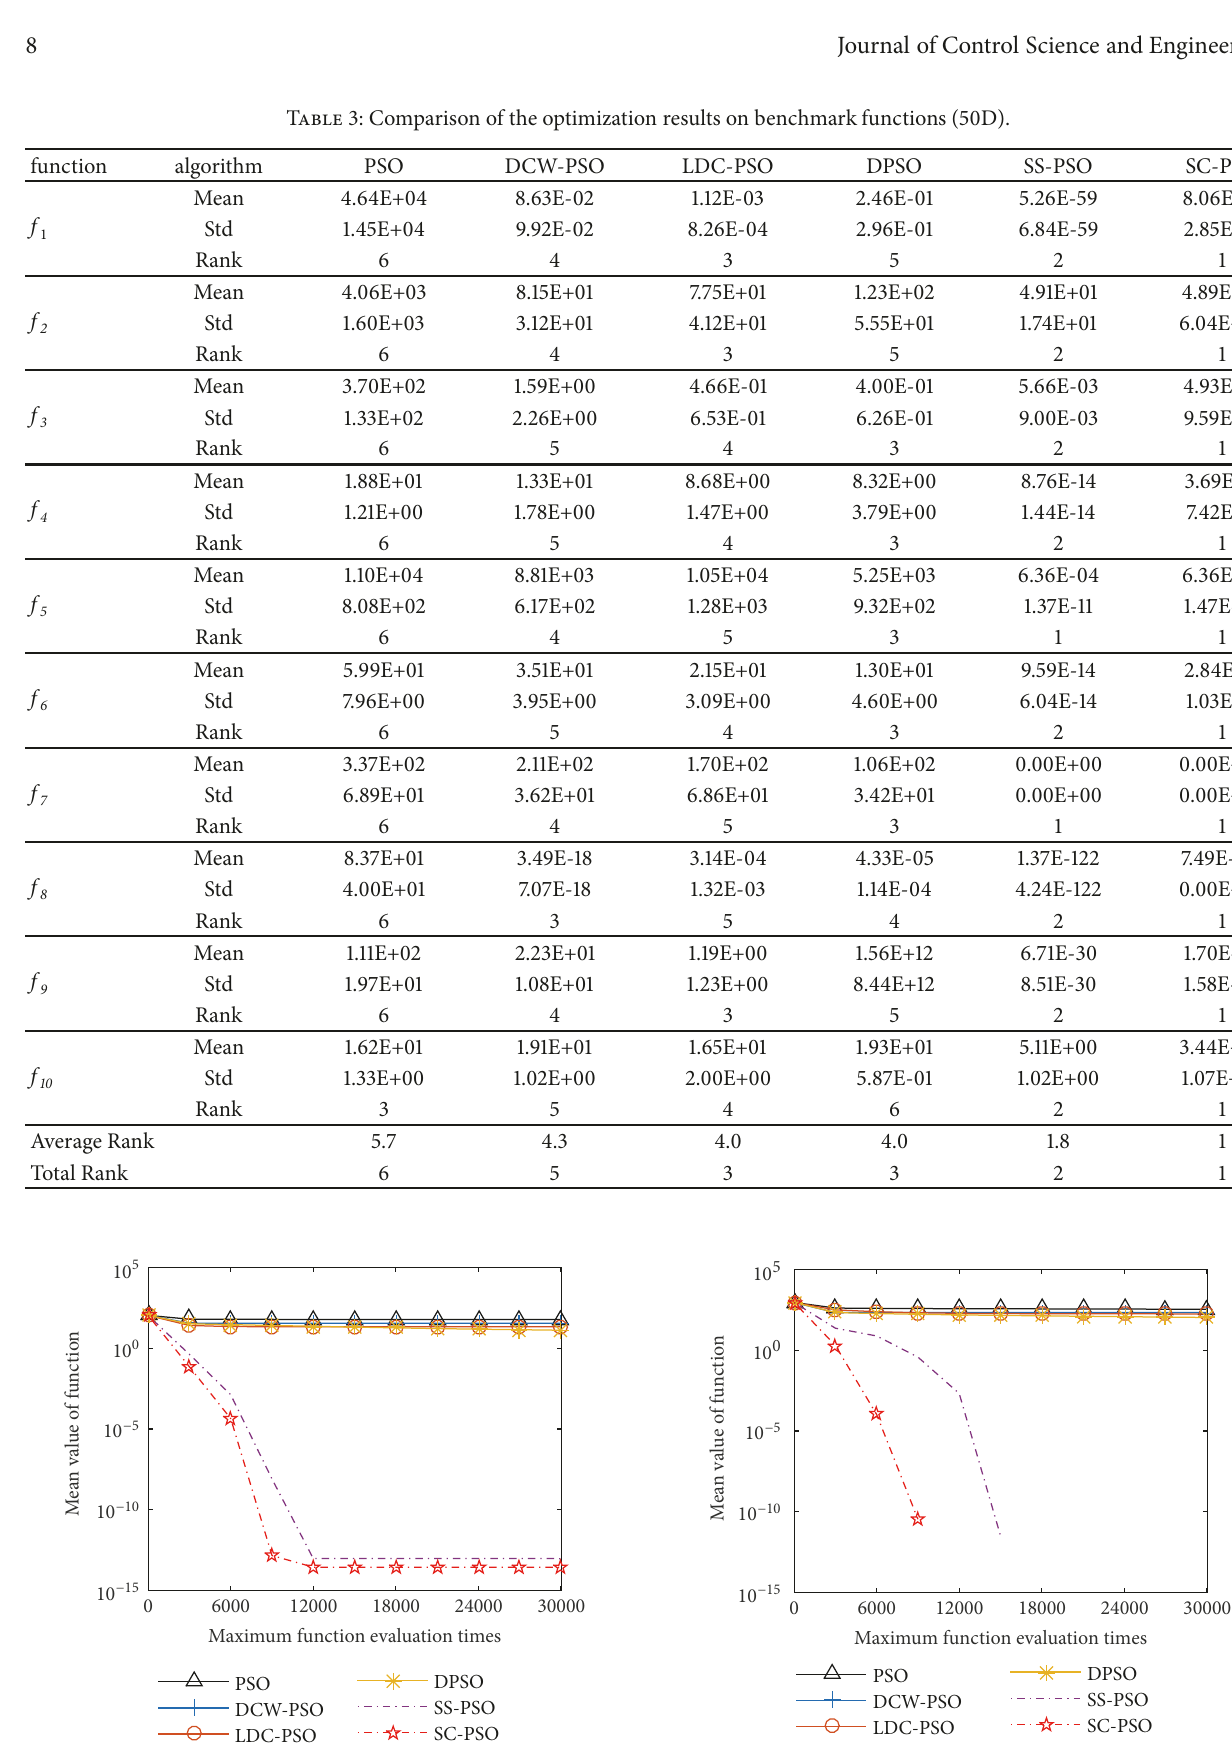
Figure 8: The function f 6 iterates over the curve. Figure 9: The function f 7 iterates over the